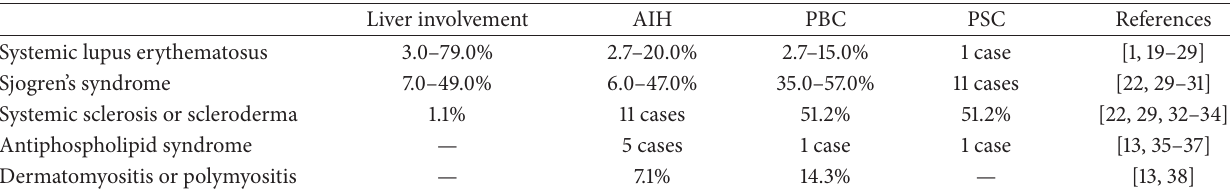
Table 2: Liver involvement in